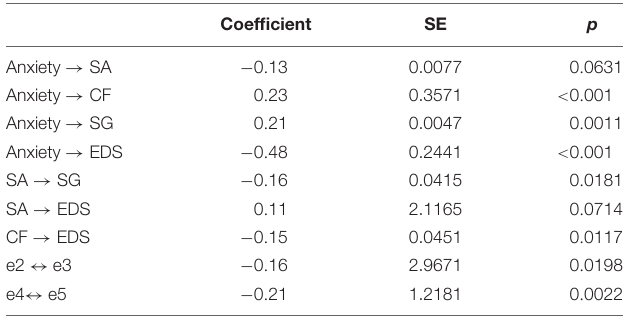
TABLE 2 | Coefficients, SEs, and significance values of each